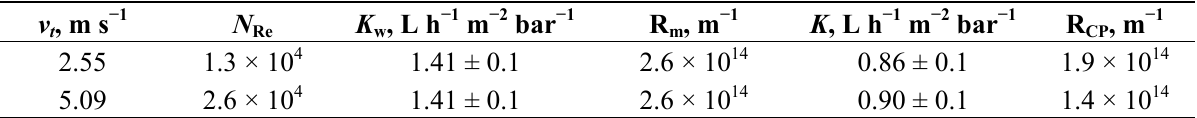
Table 4. Permeability coefficients and resistances of the selected reverse osmosis (RO)